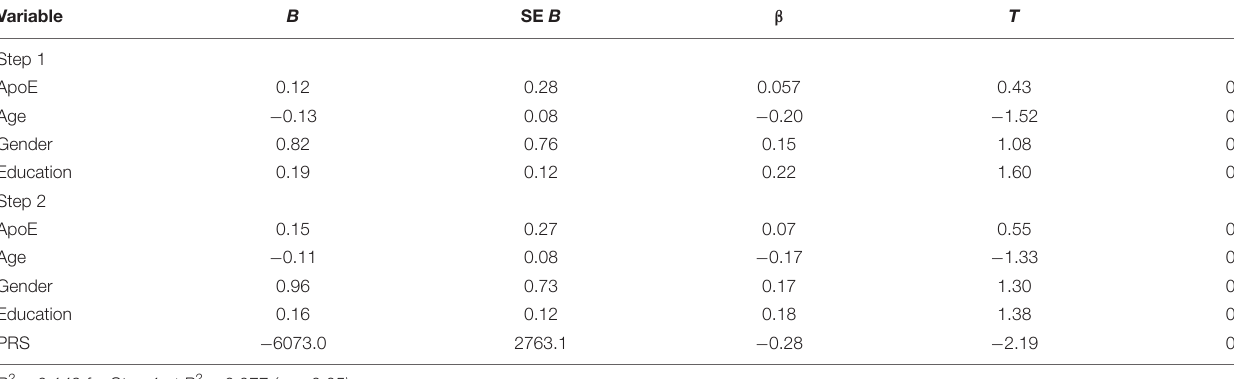
TABLE 2 | Summary of hierarchical regression analysis for variables predicting Letter Number Span performance.